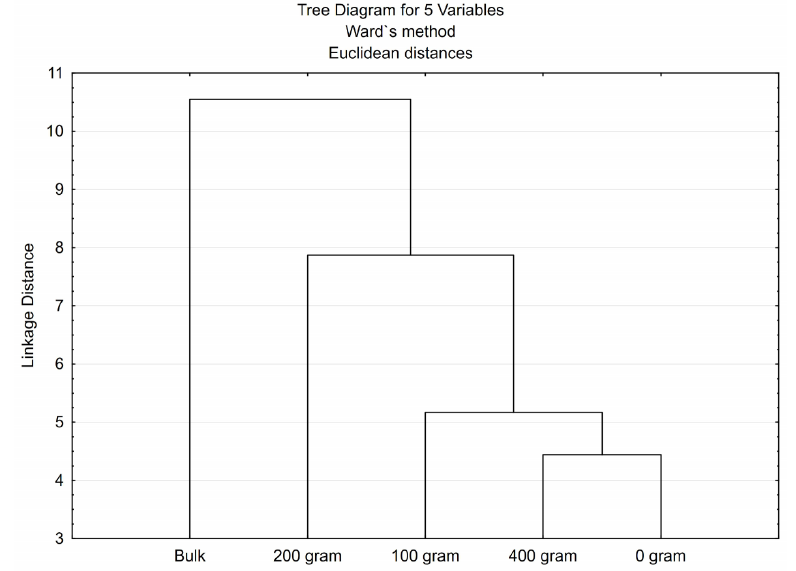
Figure 4. Dendrogram illustrating the di ff erences in the average carbon source utilization profiles between treatments. Treatments 0 = control (no rhizobium), 1 = 100, 2 = 200 and 4 = 400 grams of rhizobium per 100 kg of